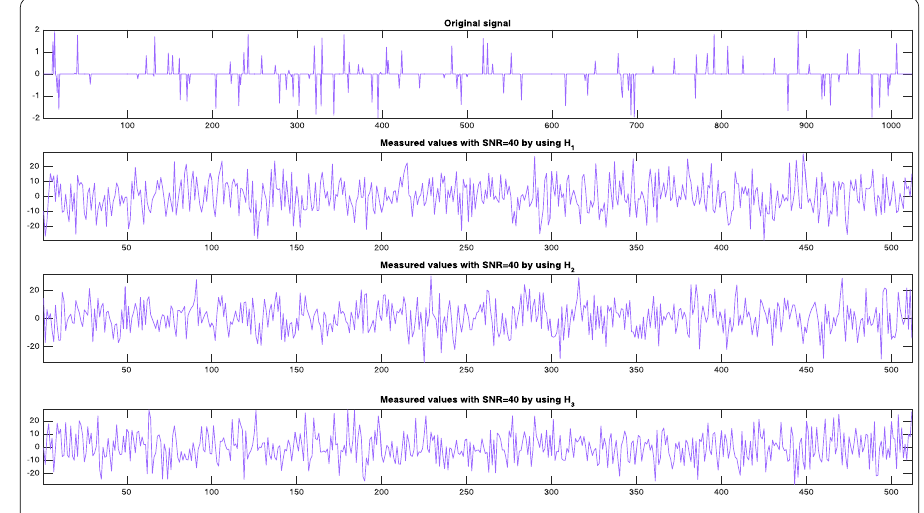
Figure 3 From top to bottom: the original signal and the measurement by using H 1 , H 2 , and H 3 , respectively, with m = 100